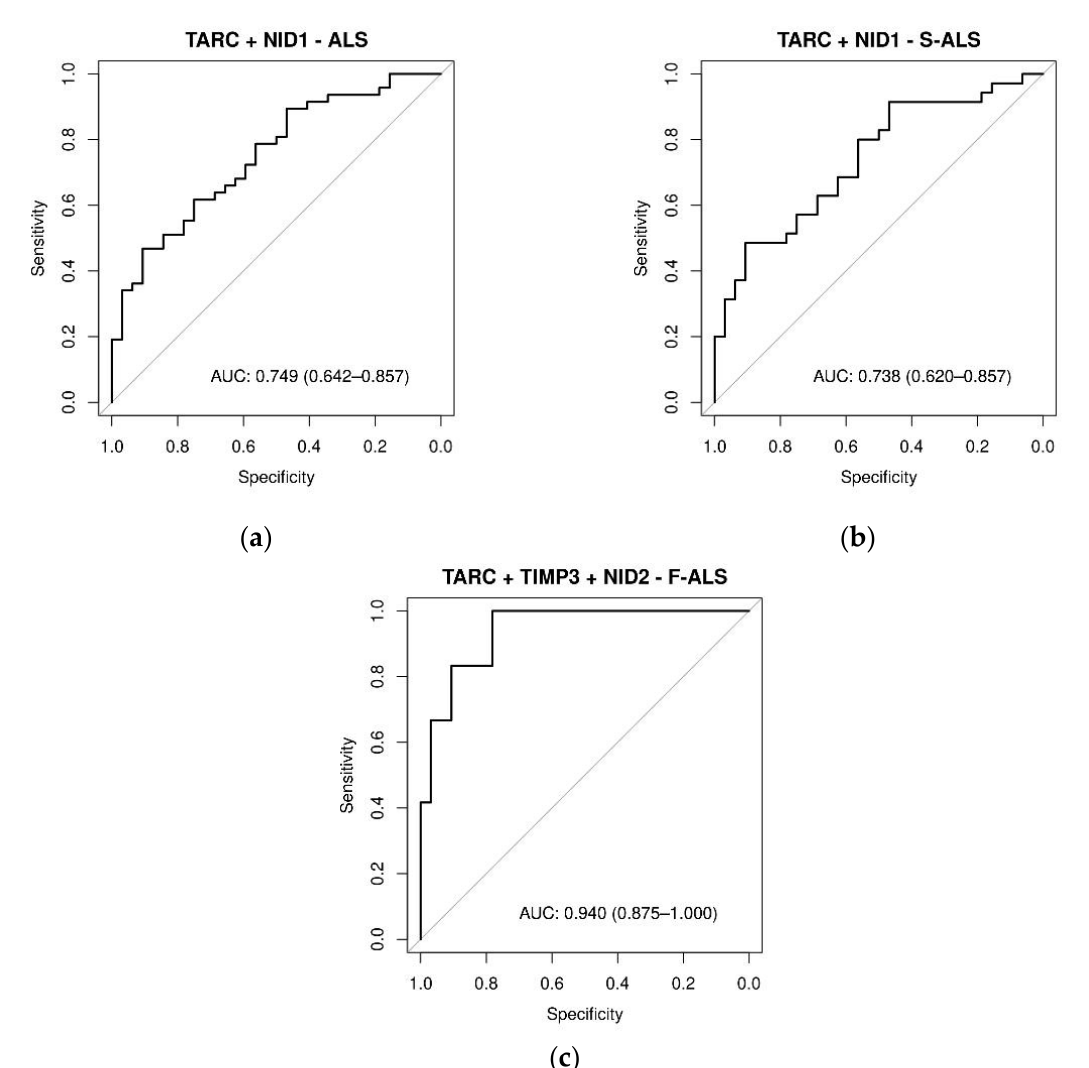
Figure 8. ROC curves of plasma proteins levels in ALS, F-ALS and S-ALS, referring to some significant linear combinations of TARC, TIMP-3, NID1 and NID2. The AUC indicate the diagnostic power: ( a ) TARC + NID1 in ALS patients (0.75), ( b ) TARC + NID1 in S-ALS patients (0.74) and ( c ) TARC + TIMP-3 + NID2 in F-ALS patients (0.94). The diagnostic model was constructed by using stepwise logistic regression analysis.